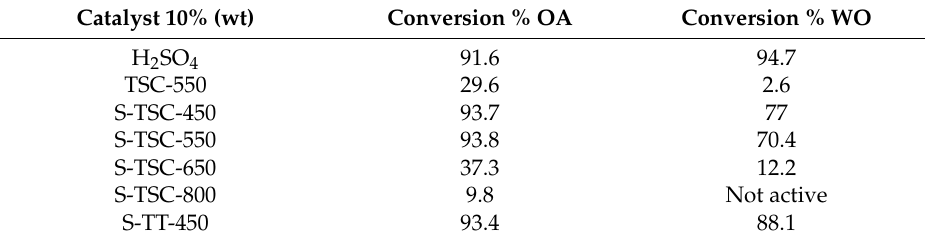
Table 6. Reaction of different catalyst in oleic acid esterification and waste oil transesterification.